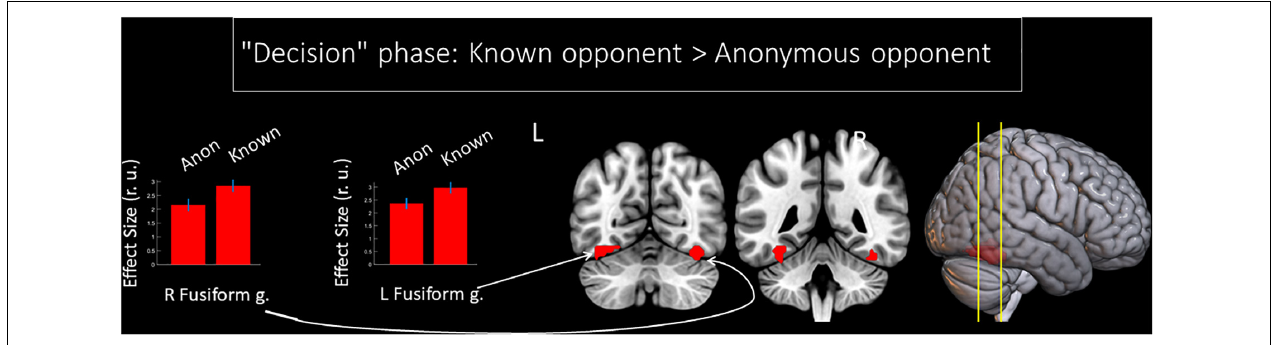
FIGURE 2 | Results of the group-level BOLD signal analysis. Clusters of increased BOLD signals associated with decision-making after being provoked for the F-contrast “Known opponent vs. Anonymous opponent” (uncorrected p < 0.001 at the voxel level, FWE-corrected at the cluster level p < 0.05, k = 15). Plots show effect sizes with 95% confidence intervals. L/R, left/right hemisphere; g., gyrus; Anon, anonymous opponent; Known, introduced opponent. TABLE 1 | Results of the group-level analysis of the BOLD signal associated with decision-making after being provoked (uncorrected p < 0.001 on the voxel level, FWE-corrected at the cluster level p < 0.05, and k = 15). Cluster Brain